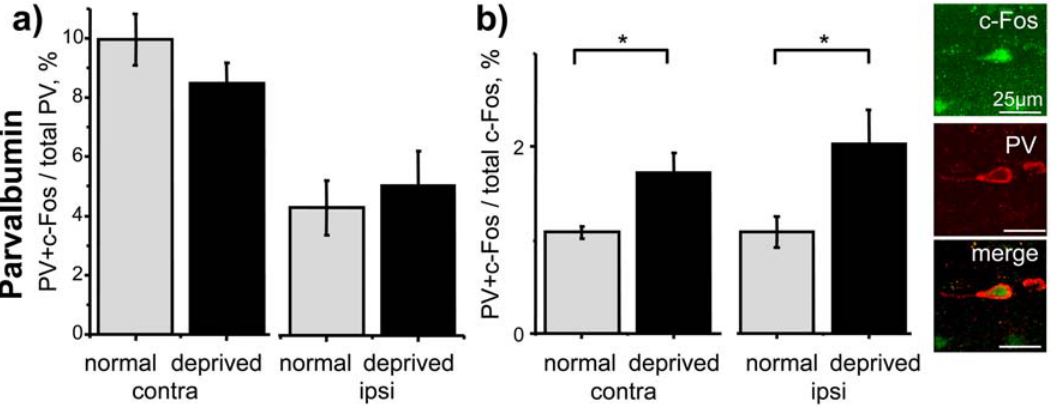
Figure 5. Effect of long-term MD on PV interneurons. a) PV interneurons did not show a significant decrease in the D/M ratio after long-term MD (contra, t test, P=0.19; ipsi, t test, P=0.65; N=11), indeed b) the proportion of c-Fos positive cells which were also PVergic (D/F ratio) was increased in MD rats (contra, t test, P=0.017; ipsi, t test, P=0.041; N=11).